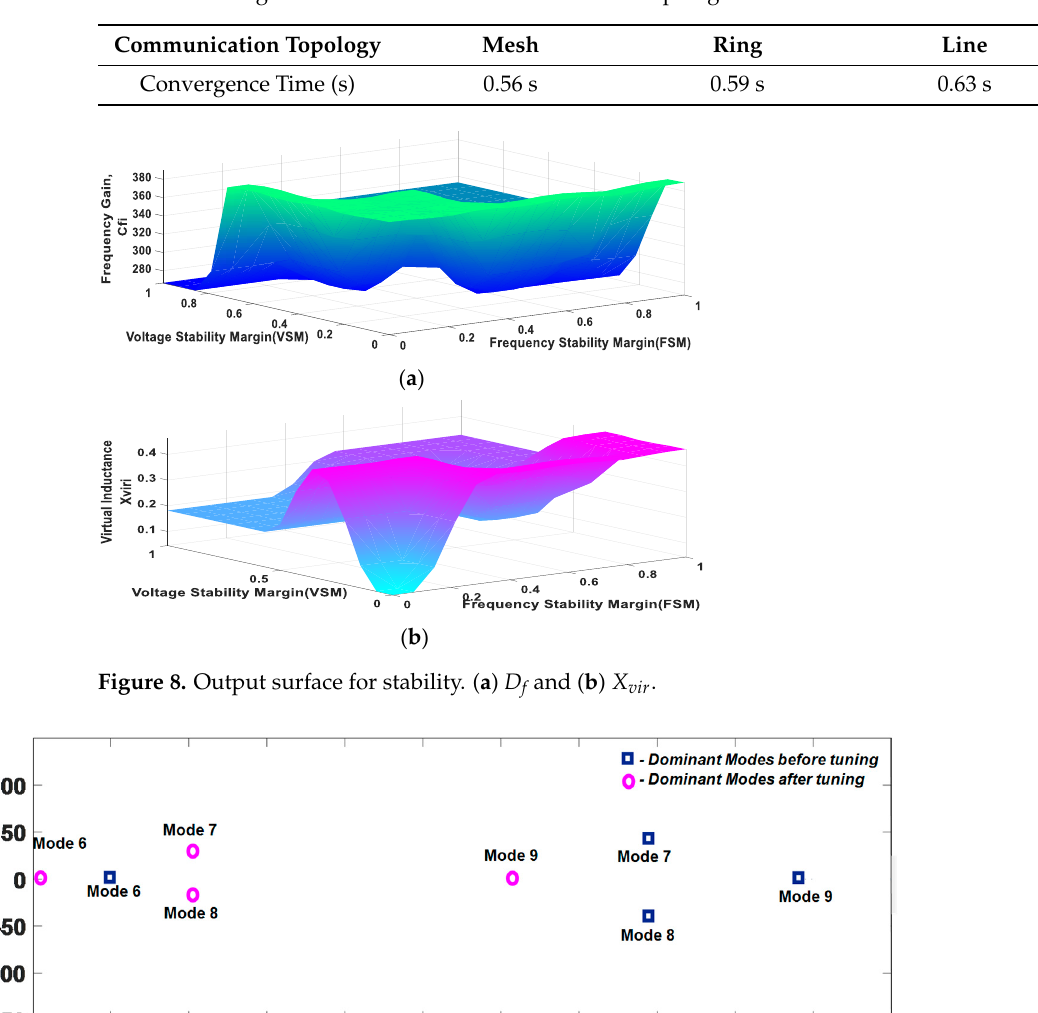
Figure 9. Comparison of dominant modes with before and after tuning of DSC for stable opera- tion. Table 2. Distributed secondary control (DSC) parameters with and without the fuzzy logic con- troller.